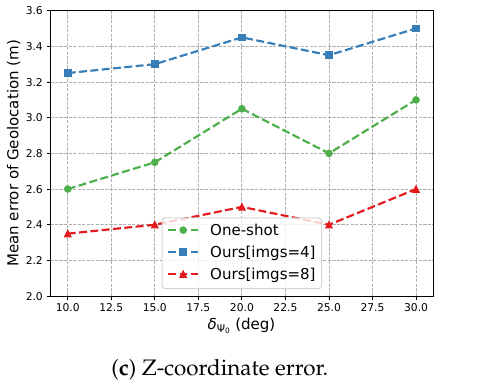
Figure 12. Geolocation errors under different yaw-angle biases.